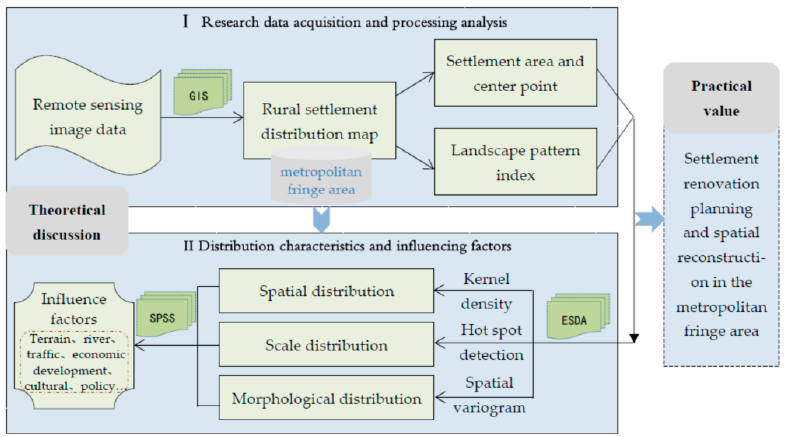
Figure 1. Theoretical analysis framework.